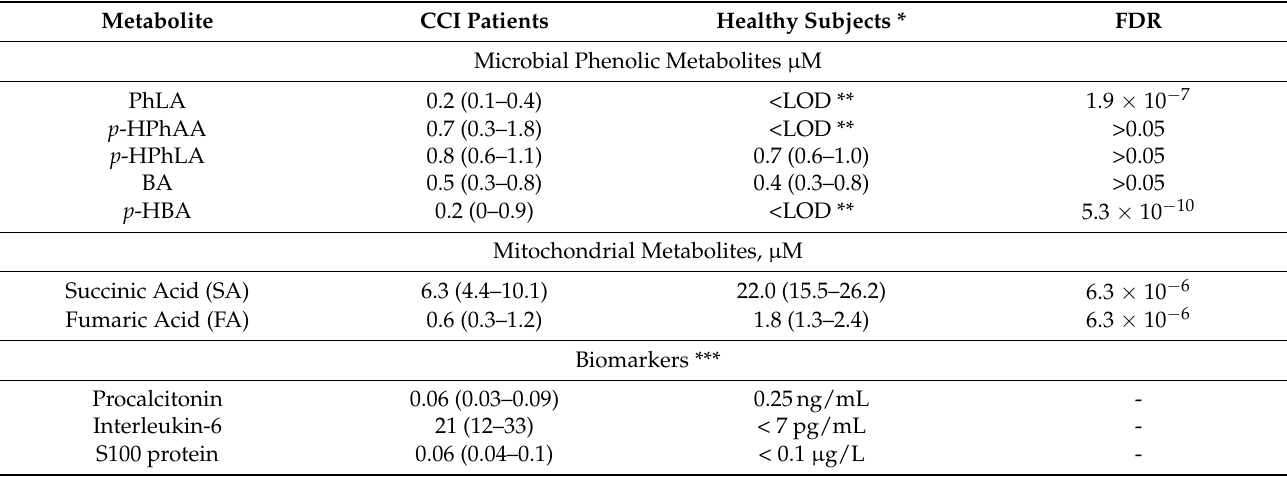
Table 1. Concentrations of the microbial and mitochondrial metabolites ( µ M) and biomarkers in the serum samples of the CCI patients ( n = 44) and healthy subjects ( n = 20), Median (IQR